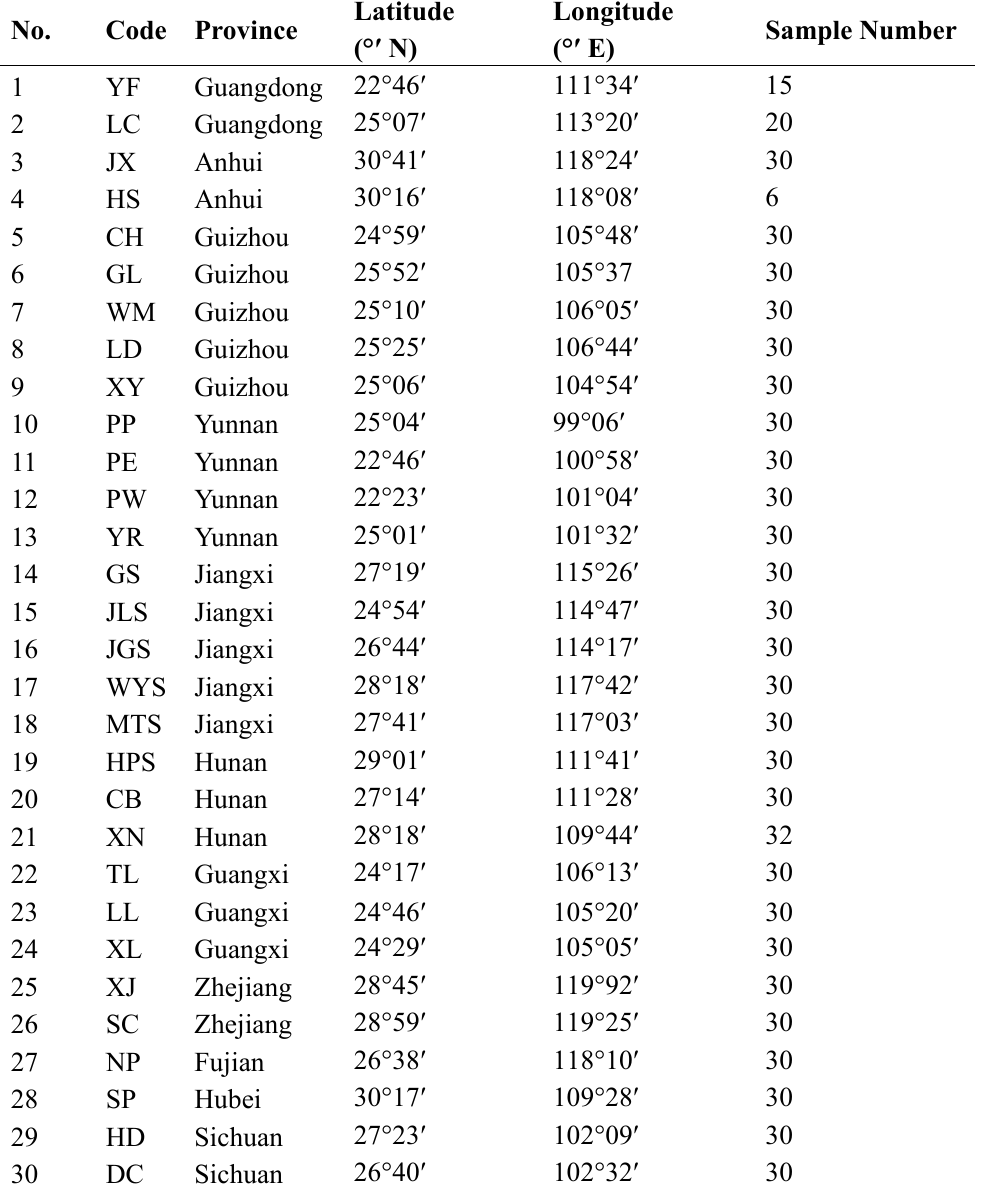
Table 1. Location of 30 populations of T. ciliata used in this